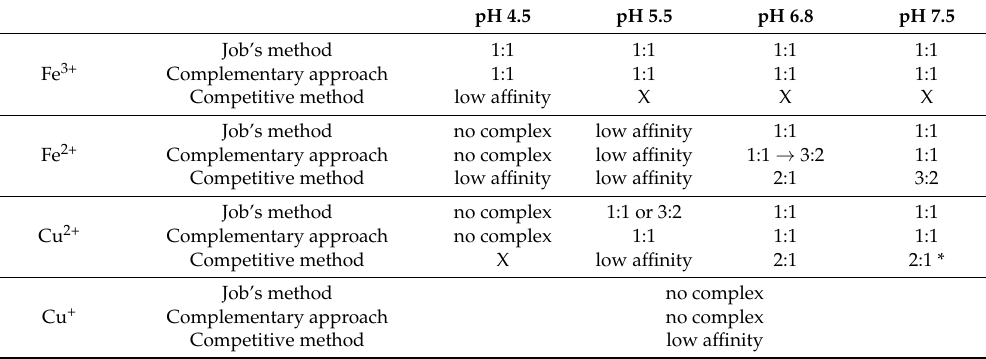
Table 1. Summarized results of the formation and stoichiometry of isoquercitrin complexes with iron and copper at all pH values analyzed.